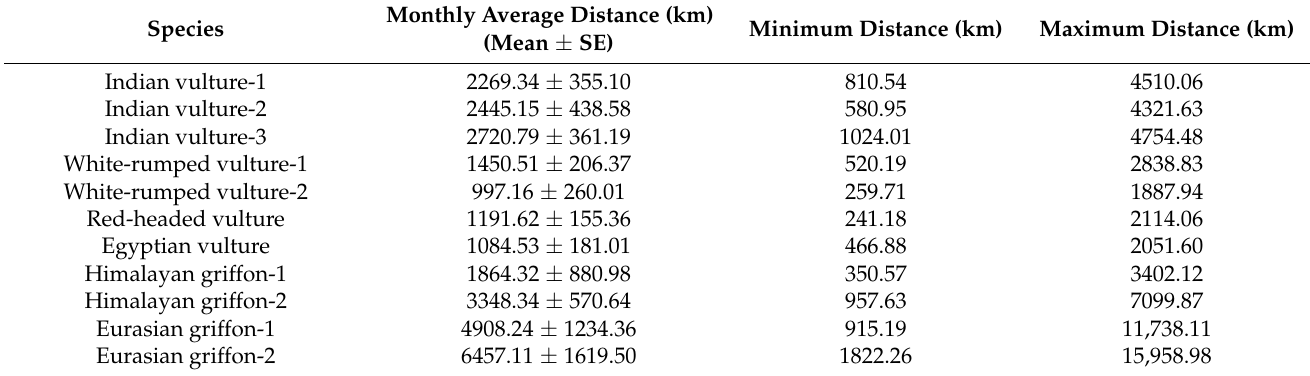
Table 2. Average (mean ± SE) monthly distances travelled by satellite-tagged